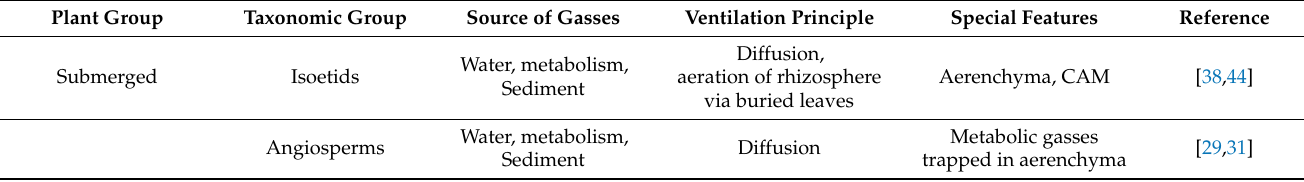
Table 2. Ventilation mechanisms in different taxonomical and functional plant groups that thrive in oxygen-deficient